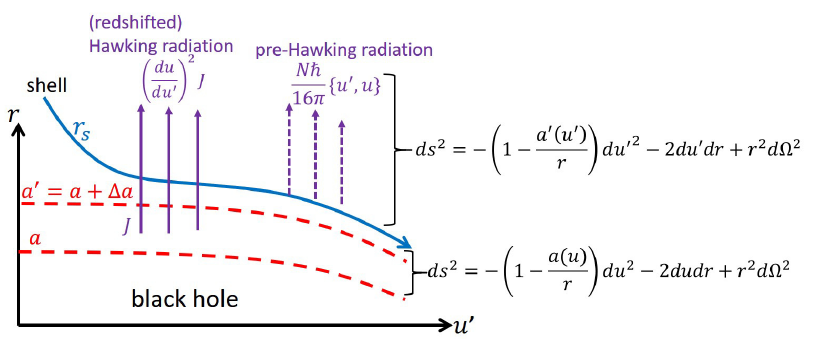
Figure 7. The system of the shell and the evaporating black hole. The pre-Hawking radiation (dashed arrows) is induced by the shell and added to the Hawking radiation (solid arrows) from the black